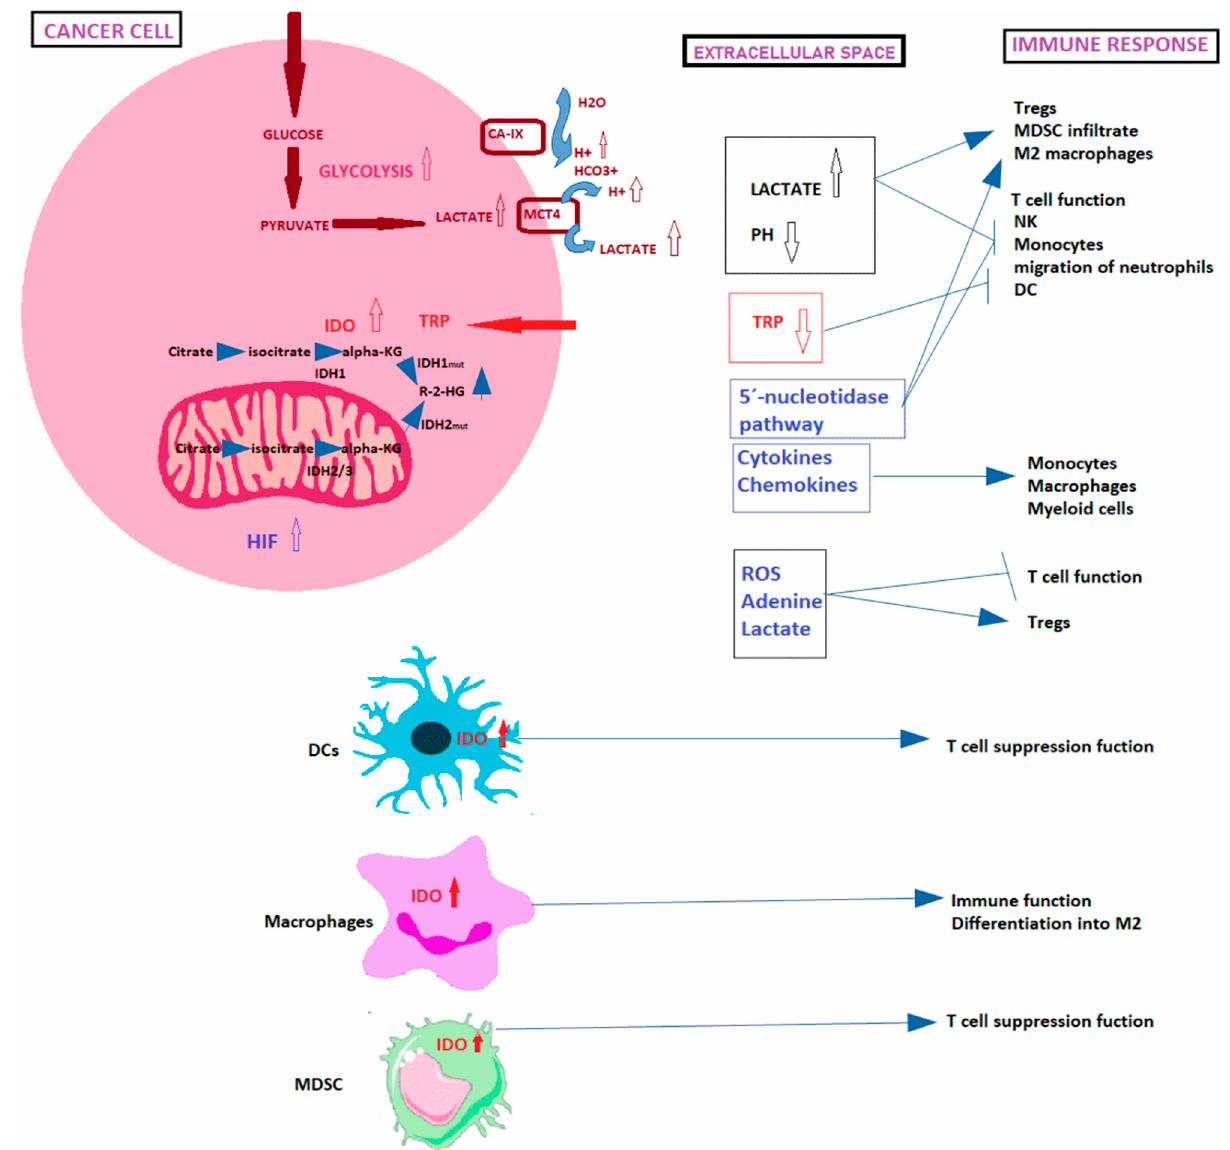
Figure 3. Mechanisms of immunosurveillance scape. Including lactate and proton release by cancer cells within the TME and the consecutive immune response, consequences of indoleamine 2,3 dioxygenase (IDO) overexpression and hypoxia and hypoxia inducible factor (HIF) production by cancer cells on the antitumoral immune response, and lastly Isocitrate dehydrogenase (IDH) mutations in cancer cells, promoting the accumulation of R-2-HG oncometabolite. Dendritic cells (DCs), tryptophan (TRP), myeloid-derived suppressor cells (MDSC); Reactive Oxygen Species (ROS); natural killer cells (NK); dendritic cells (DC), regulatory T cells (Tregs).